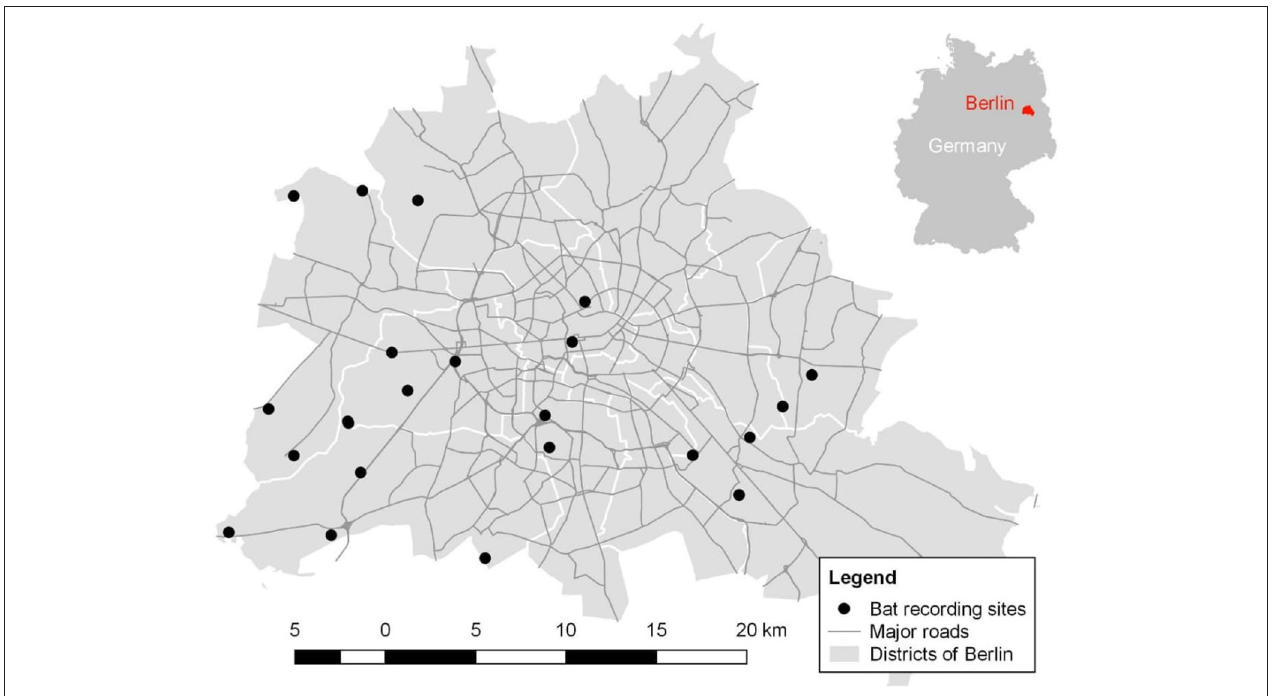
FIGURE 1 | Spatial distribution of the 22 study sites across the districts in Berlin outlined by white borders. Gray lines indicate major streets and